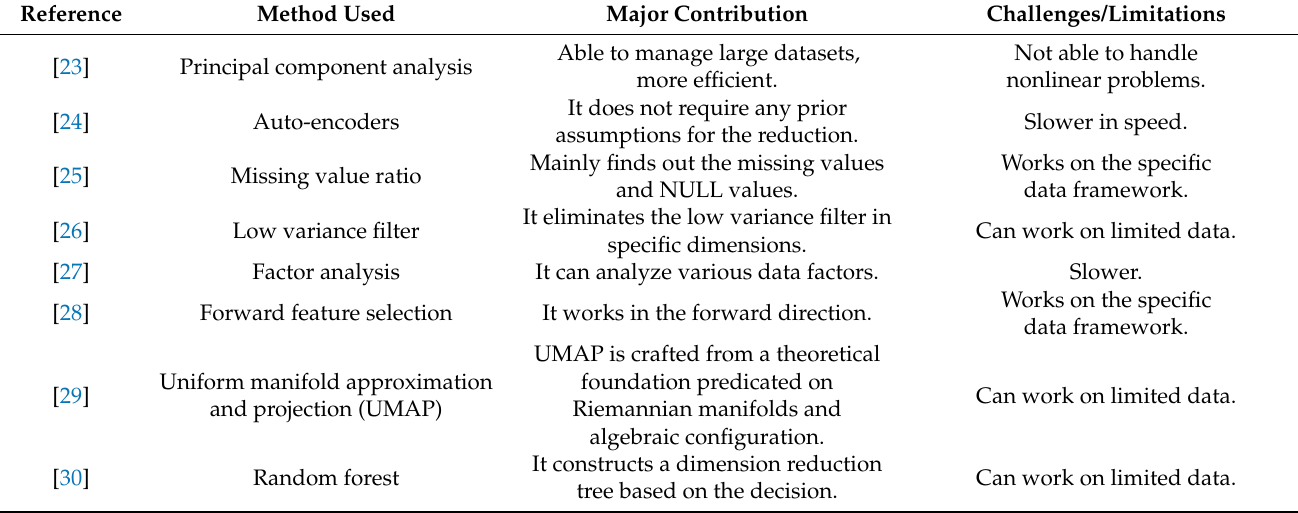
Table 3. Comparison of existing research based on dimensionality reduction in